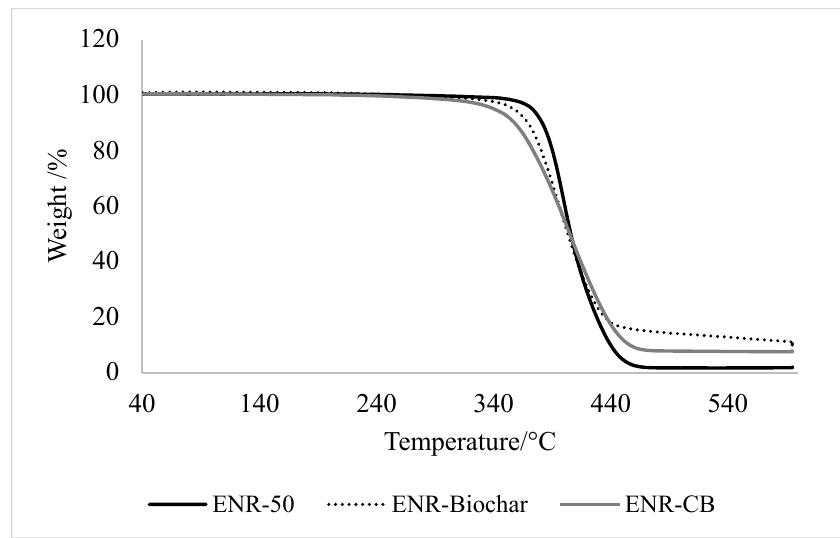
Figure 8. TGA of ENR vulcanizates.